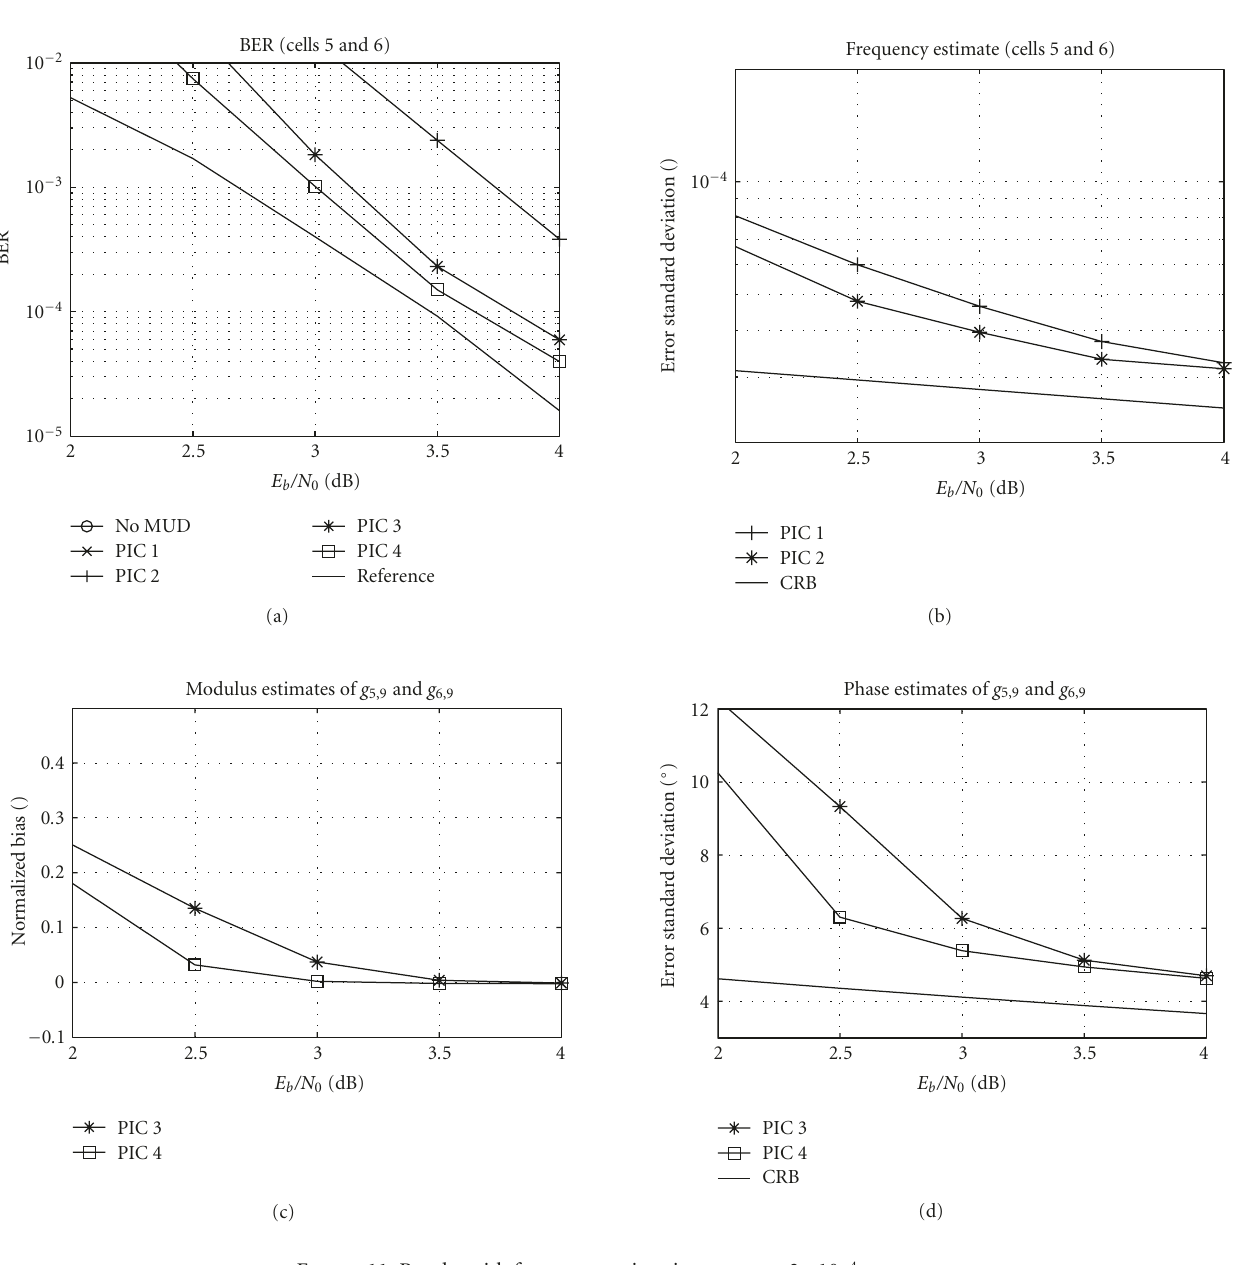
Figure 11: Results with frequency estimations: σ Δ fT = 2 · 10 − 4 , case